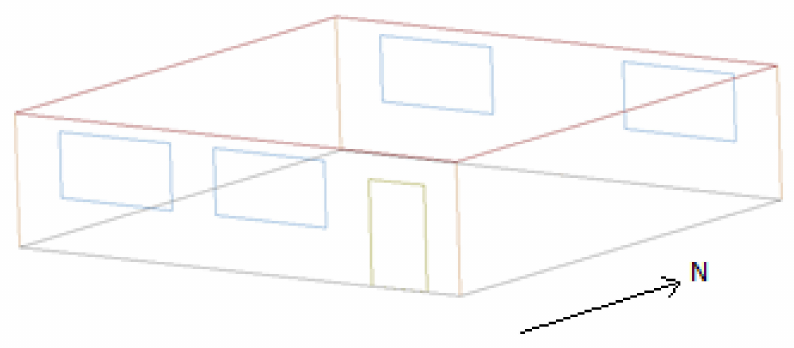
Figure 4. Geometry of the simulated dwelling. Source: own elaboration based on EnergyPlus.